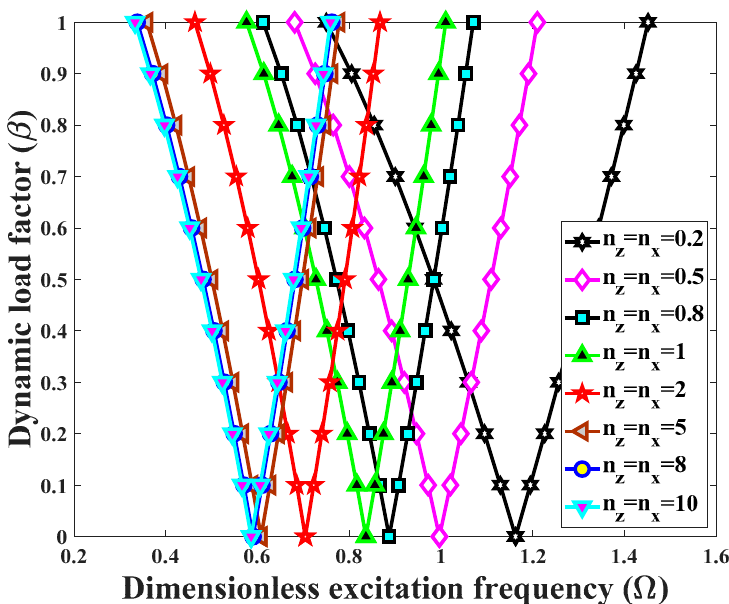
Figure 9. Effect of the longitudinal and transverse power indexes on the DIR for a FG cylindrical shell with R = 0.5 m, h / R = 0.02, L / R = 1, α =